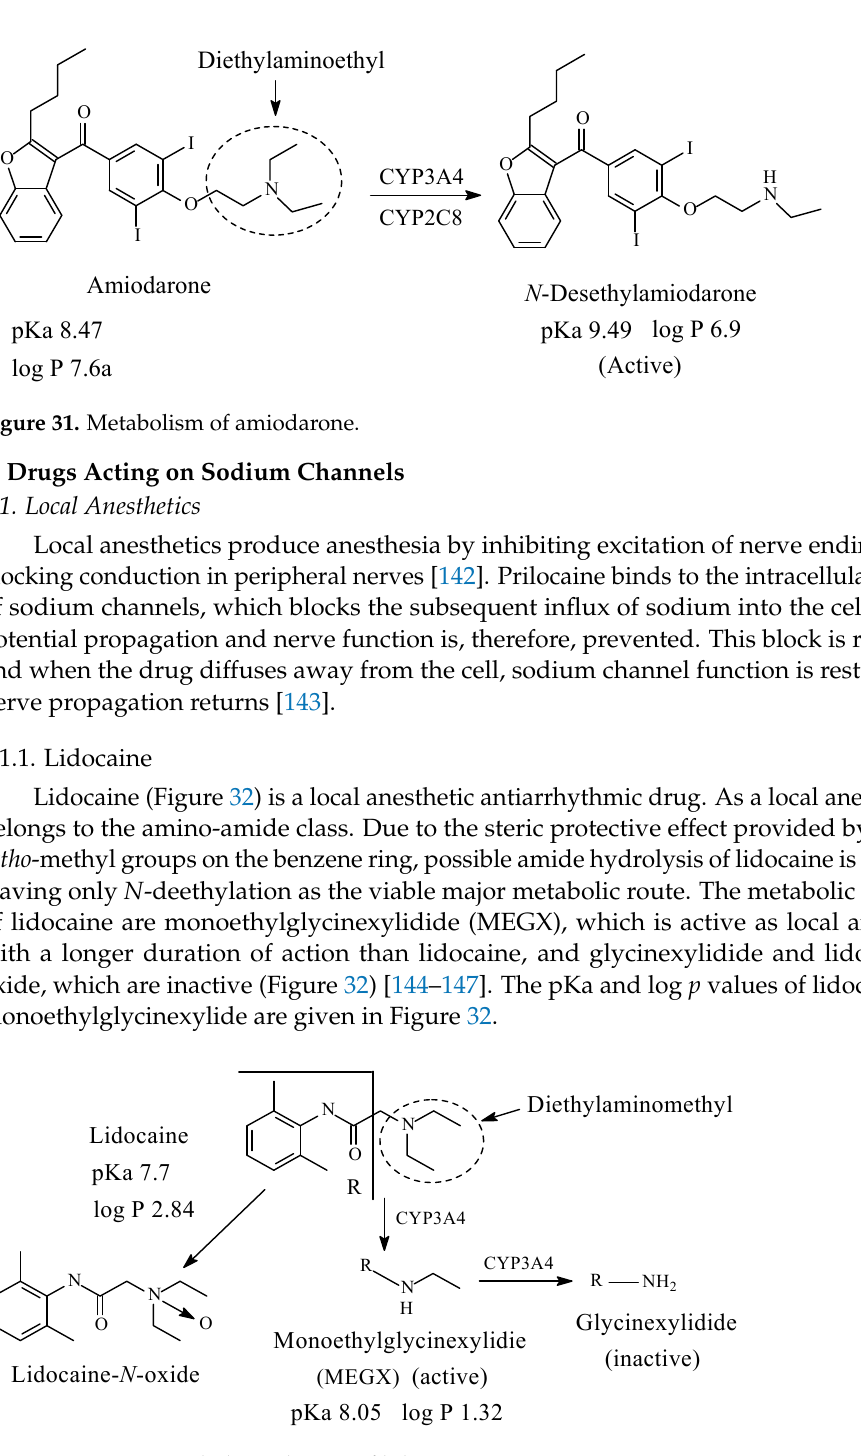
Figure 30. Metabolic pathways of diltiazem.